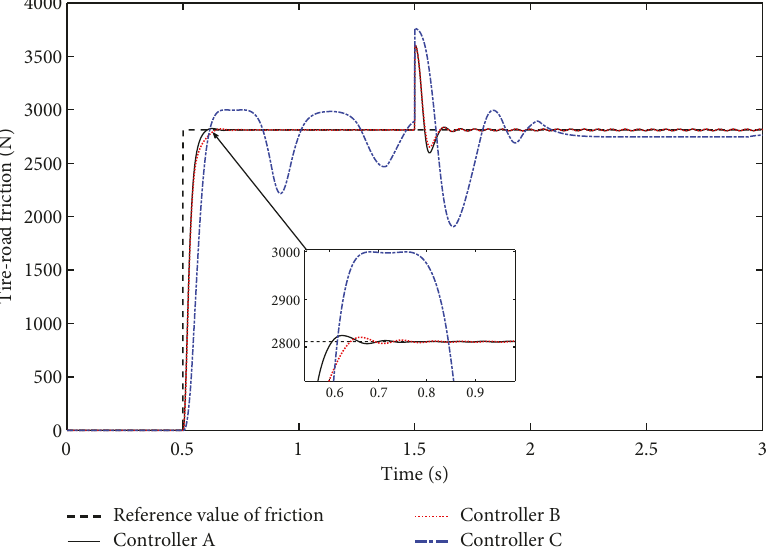
Figure 9: Reference and real value of friction.